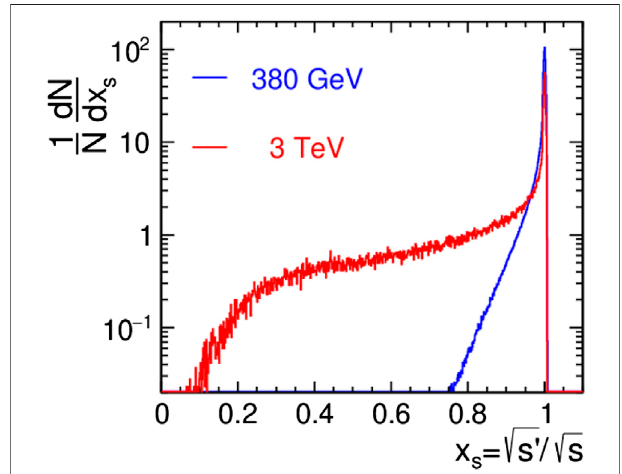
FIGURE 3 | Differential luminosity as a function of normalized centre-of- mass energy, x s (cid:1) 380 GeV and 3 TeV